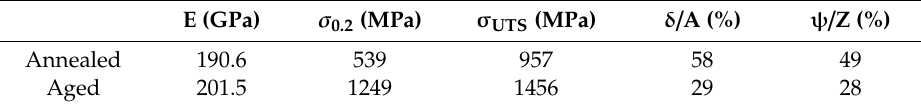
Table 4. Mechanical properties before and after heat